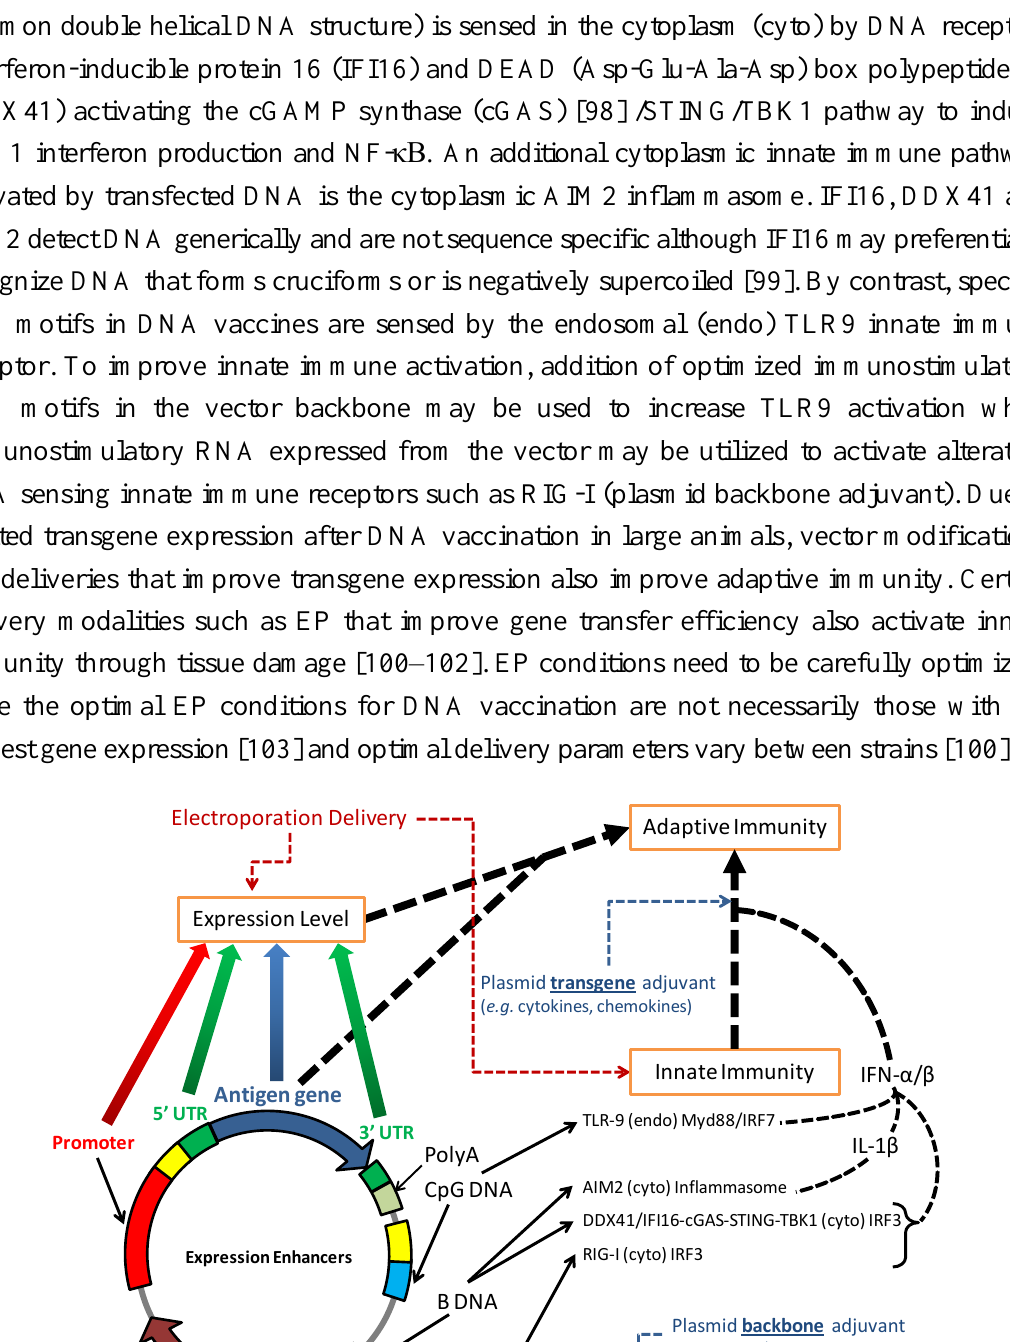
Figure 4. Molecular mechanisms of DNA vaccines. Transfected B DNA (the most common double helical DNA structure) is sensed in the cytoplasm (cyto) by DNA receptors interferon-inducible protein 16 (IFI16) and DEAD (Asp-Glu-Ala-Asp) box polypeptide